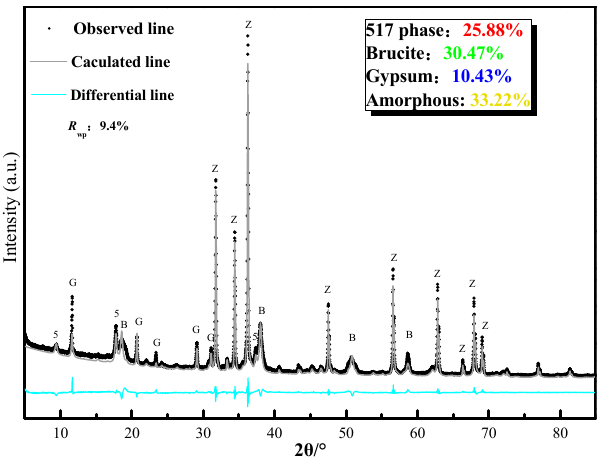
Figure 6. Rietveld fitting results for 517 phase after immersing hardened paste in CaCl 2 solution for